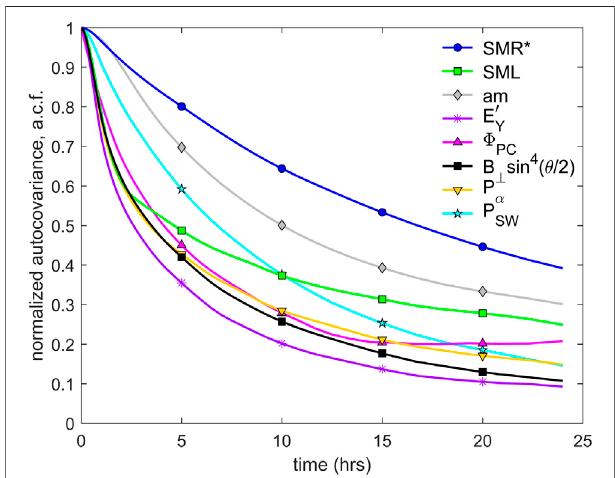
FIGURE 5 | Normalized autocovariance functions of 60-point (hourly) 1- min values of: (black line with fi lled square symbols) an estimate of the geoeffective IMF component of the interplanetary magnetic fi eld, B ⊥ sin 4 ( θ /2); (purple with asterisk symbols) the half-wave recti fi ed dawn-dusk componentoftheinterplanetarymagnetic fi eld, E Y ′ (where E Y ′ = E Y when E Y ′ > 0 and E Y ′ = 0 when E Y < 0); (cyan with star symbols) the solar wind dynamic pressure, P SW ; (mauve with upward-pointing triangle symbols) the transpolar voltagemeasuredbytheSuperDARNradararray, Φ PC (1 minvalues,obtained from linear interpolation between hourly values are used); (gray with diamond symbols) the am geomagnetic index (1 min values, obtained from linear interpolationbetween3-hourlyvaluesareused);(greenwithopensquares)the SuperMAG SML auroral electrojet index; (blue with circle symbols) the pressure-corrected SuperMAG geomagnetic index SMR * (dominated by the effect of the ring current). All curves are for all available data for 1996 – 2019, inclusive. Note that the symbols have been added at intervals of 5 h to help distinguish between the different color lines. but a.c.f.s were computed for lags 1 min